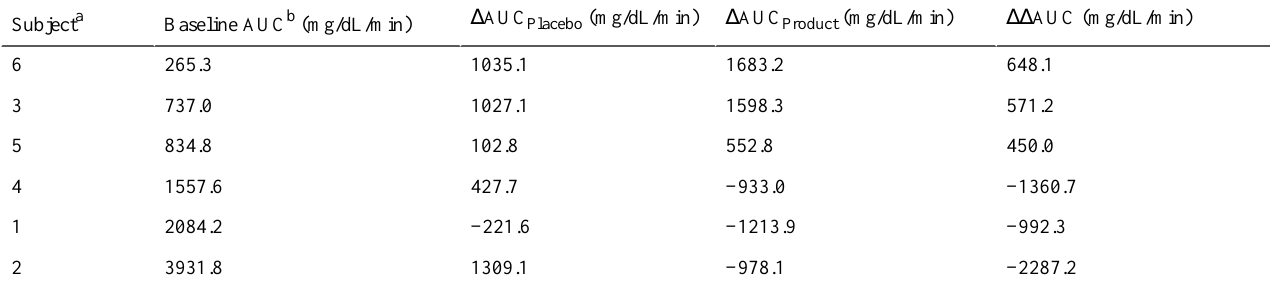
Table 1. Subjects ranked by baseline value of area under the glucose